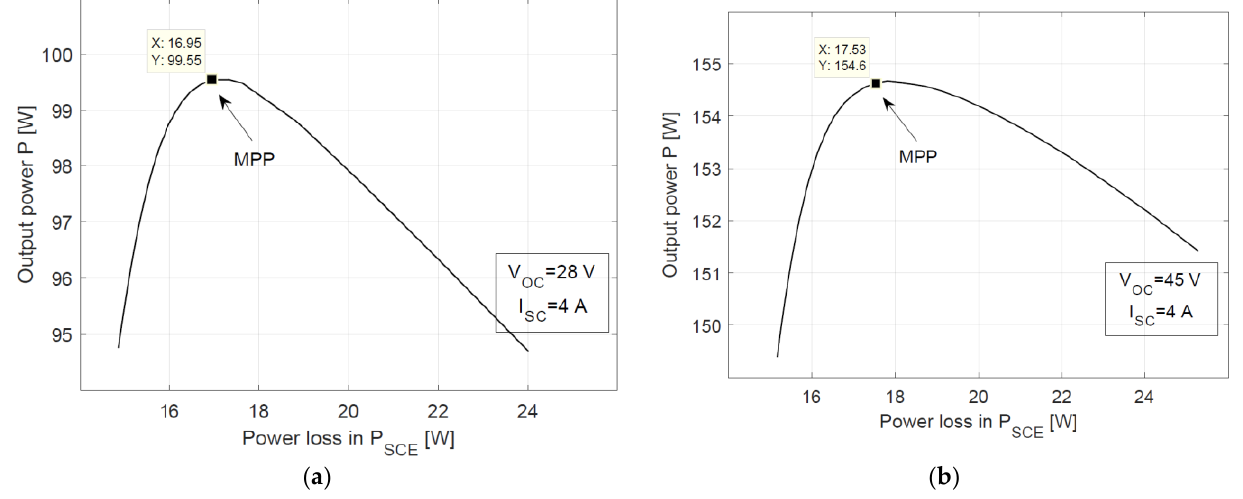
Figure 12. P CE power loss in CE as a function of output power P (at MPP): ( a ) For output power 99.55 W, P CE = 16.95 W; ( b ) For output power 154.6 W, P CE = 17.53 W. 99.55 W, P CE = 16.95 W; ( b ) For output power 154.6 W, P CE = 17.53